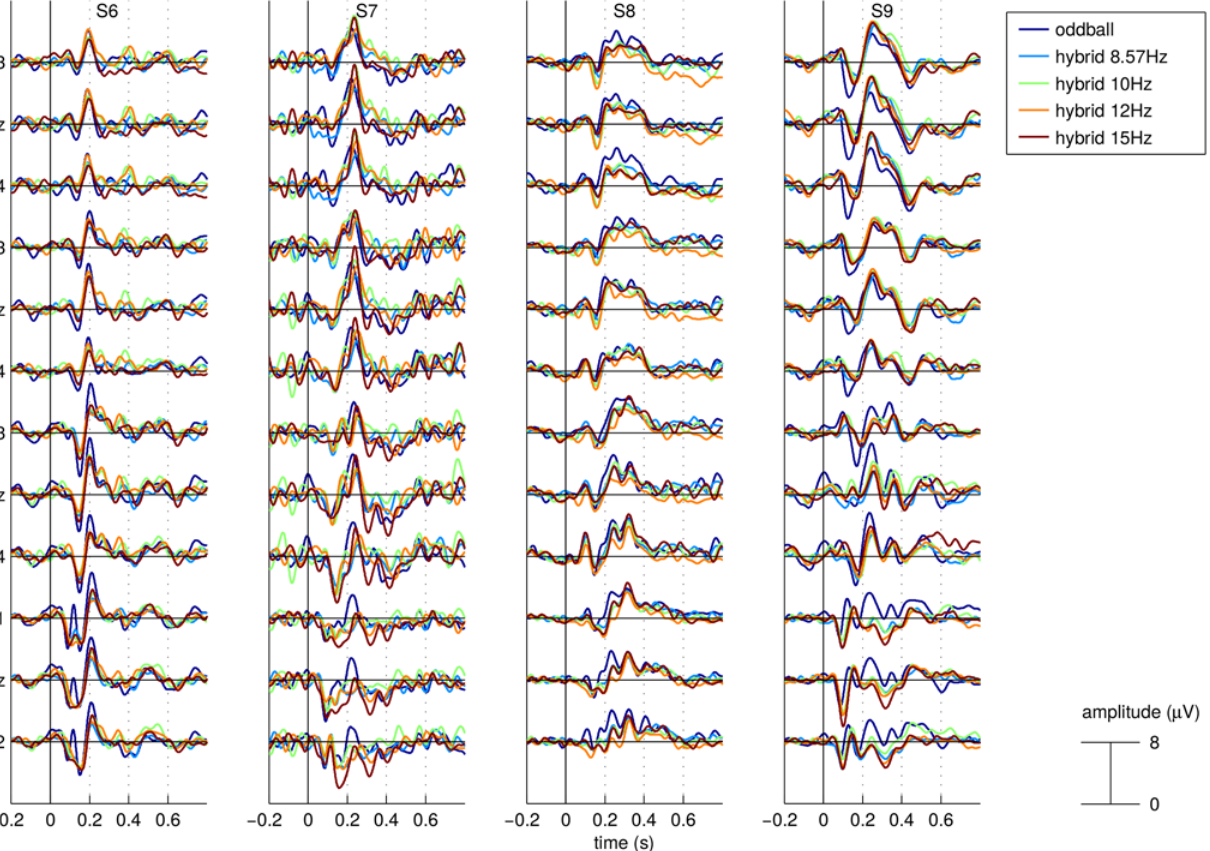
Fig 4. Average ERP responses to the target stimuli. ERPs are shown for a selection of EEG channels covering the scalp from frontal to occipital locations for all 5 experimental conditions and for subjects S06 to S09. Time 0 represents stimuli